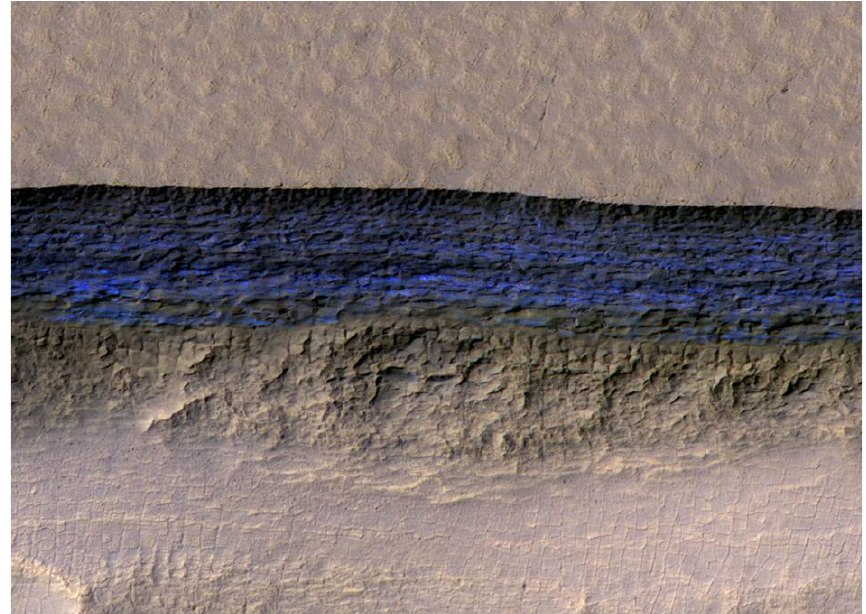
Figure 12. A cross-section of underground water ice is exposed at the steep slope that appears bright blue in this enhanced-color view from the Mars Reconnaissance Orbiter (MRO). The scene is about 500 m wide. The scarp drops about 128 m from the level ground. The ice sheets extend from just below the surface to a depth of 100 m or more [177,178].